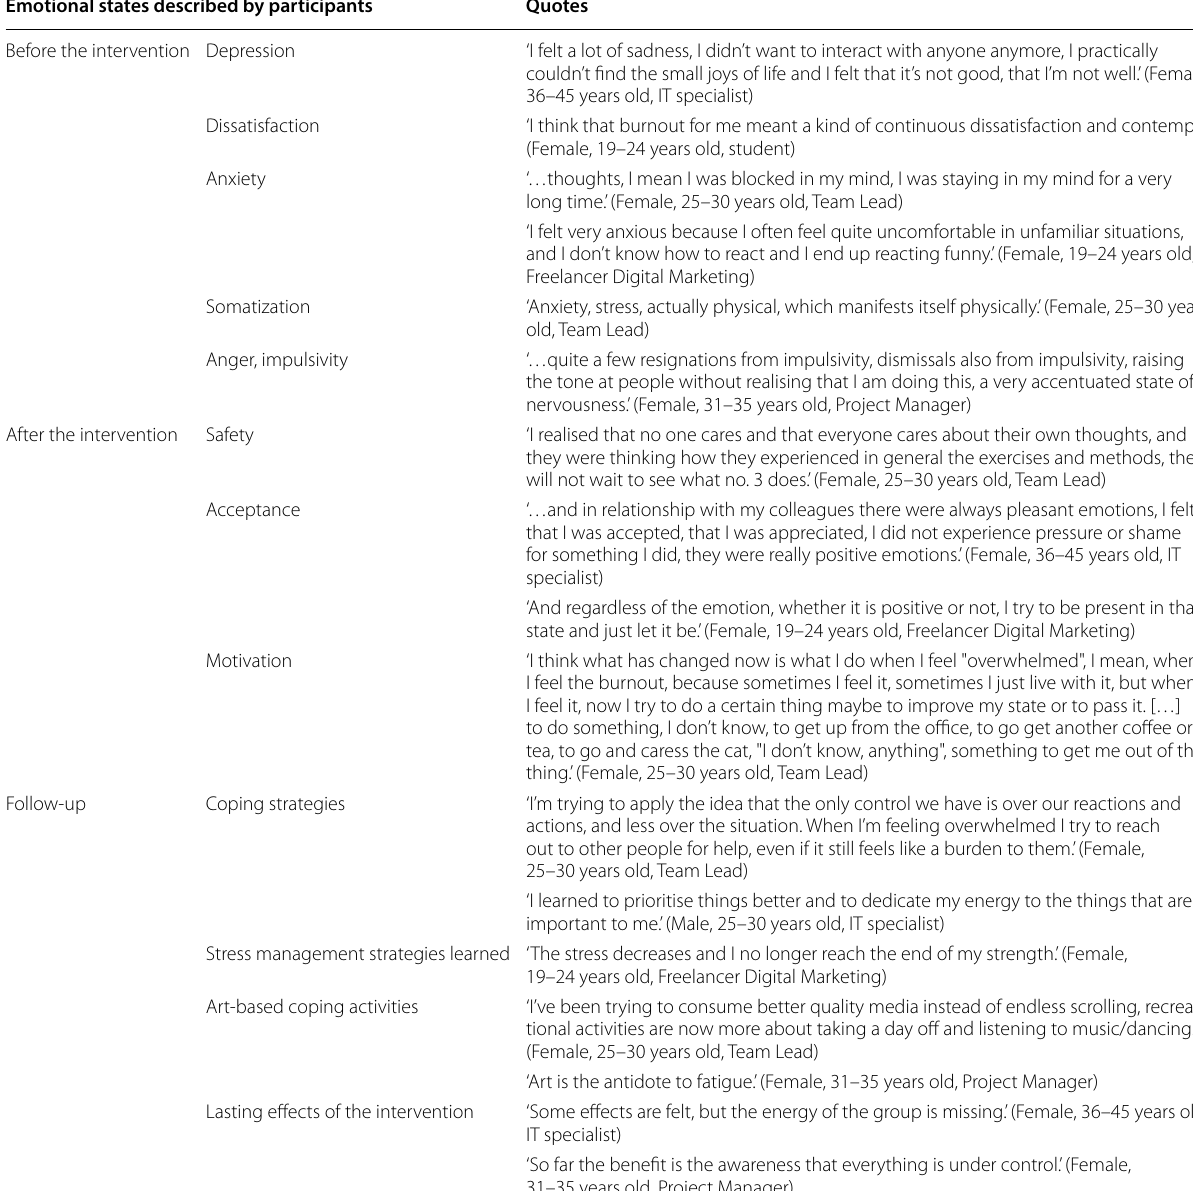
Table 1 Well‑being Outcomes—Synthesis of qualitative assessment Source: Authors’ elaboration Emotional states described by participants Quotes Before the intervention